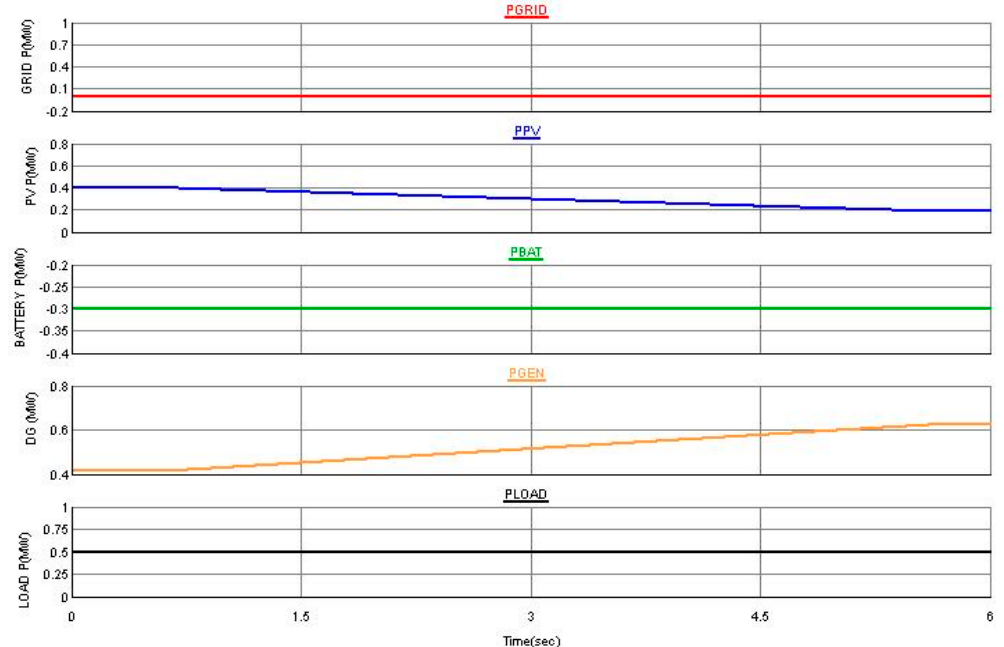
Figure 17. Grid power P GRID , PV array output power P PV , battery power P BAT , generator power P GEN and load power P LOAD.